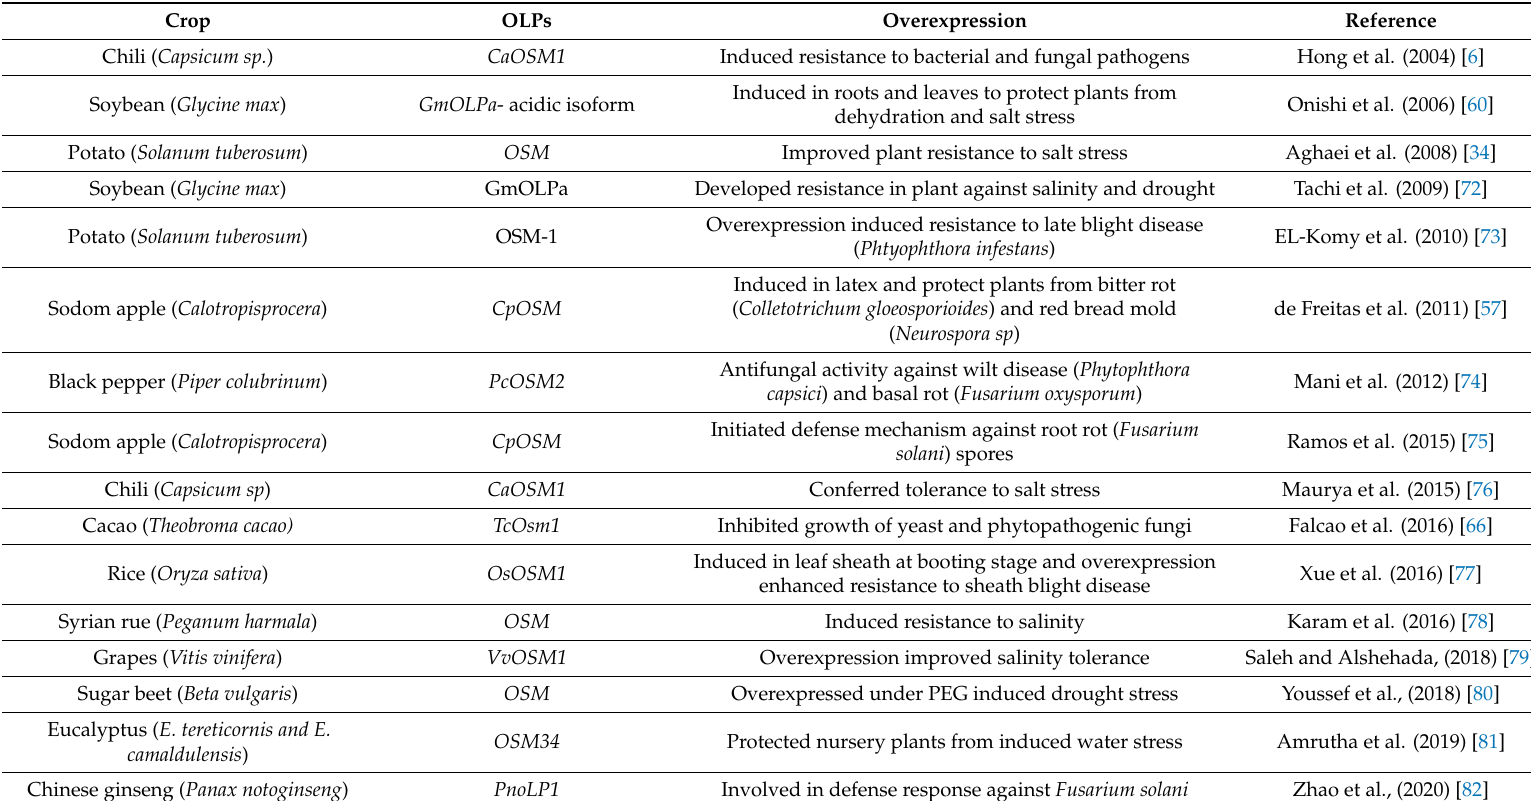
Table 1. Overexpression of osmotin-like proteins (OLPs) confers stress tolerance in